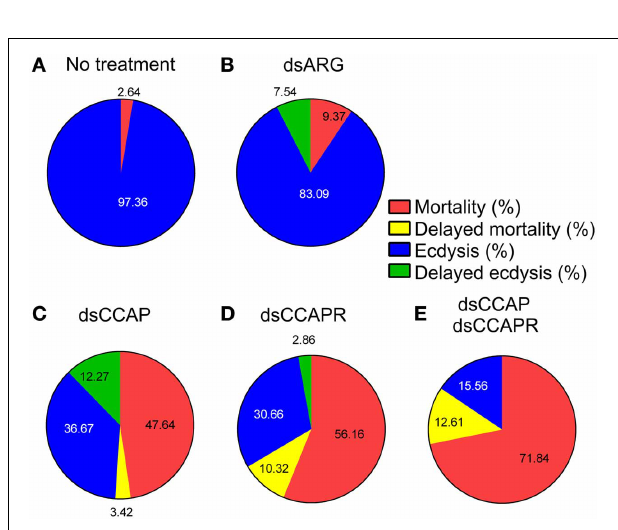
ecdysis timing that was delayed (i.e., shifted to the right) compared to the control insects with some insects being delayed 24 days PF. Each group consisted of 20–30 bugs and this experiment was repeated 3 times. Values are expressed as the mean ± s.e.m. ( n = 3).